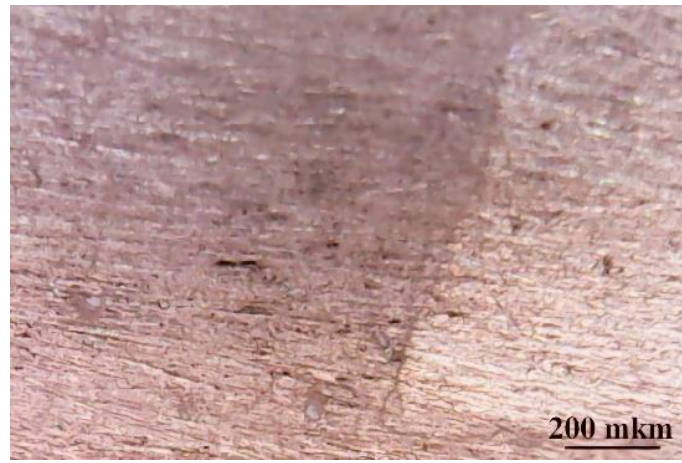
Figure 1. Optical microscopy (magnification ×500) varnish/xylene/filler KPT-8: 10/10/1 film.